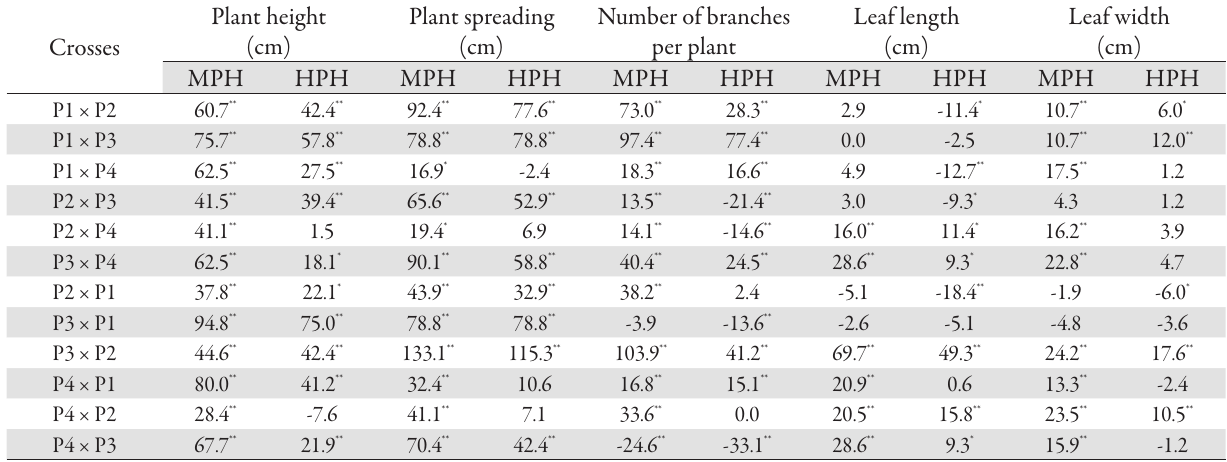
Tab. 7. Estimates of heterosis relative to mid (MPH) and high parents (HPH) for 5 plant characteristics in petunia